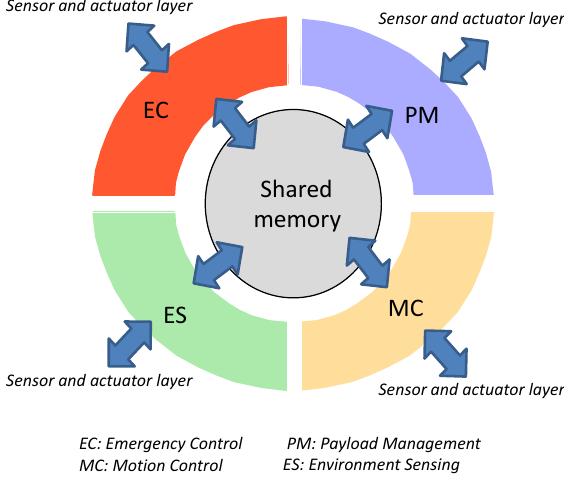
Figure 1: Functional view of the subsystems